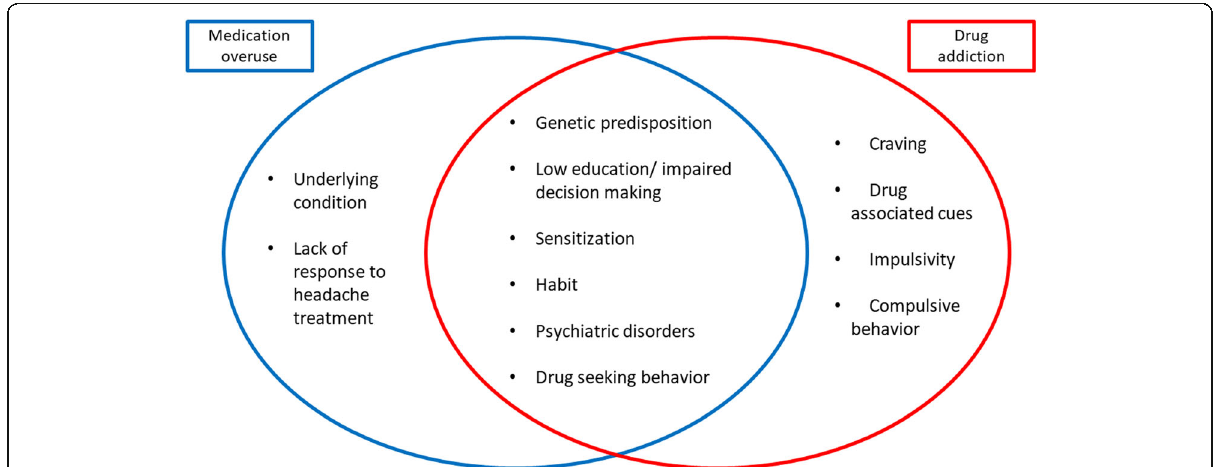
Fig. 1 Simplified schematic of behaviors expressed by MO and drug addiction